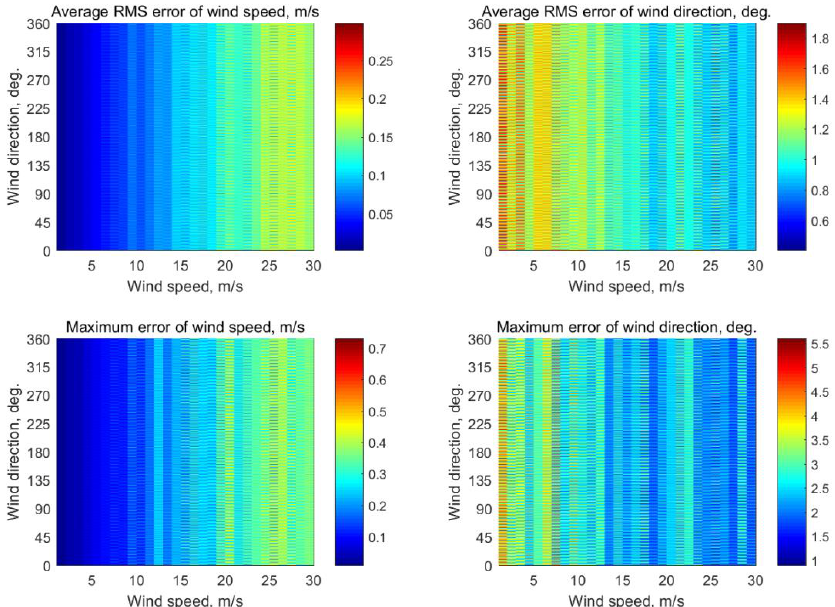
Figure A19. Simulation results of the use of four incidence angles of 30 ◦ , 35 ◦ , 40 ◦ , and 45 ◦ for wind retrieval.